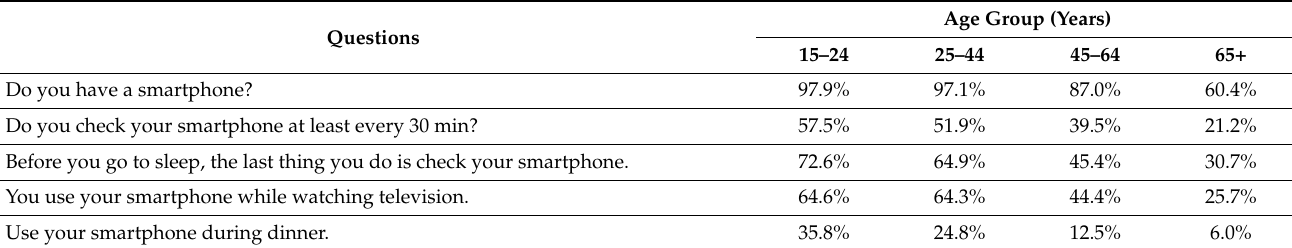
Table 8. Smartphone usage habits by age group in Canada (2018)